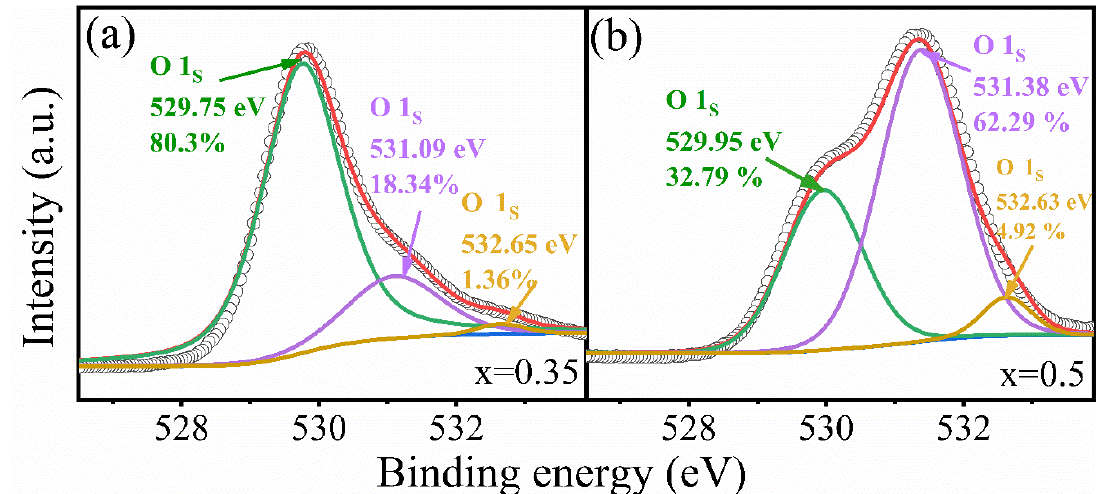
Figure 5. High-resolution XPS spectra of O 1 s of the Na 0.5 Bi 0.35 TiO 3 ( a ) and Na 0.5 Bi 0.5 TiO 3 ( b ). Table 1. Humidity response linearity (R 2 ), humidity of physical adsorption (RH p ), and the fractions of oxygen vacancies (f O ) for the Na 0.5 Bi x TiO 3 samples.